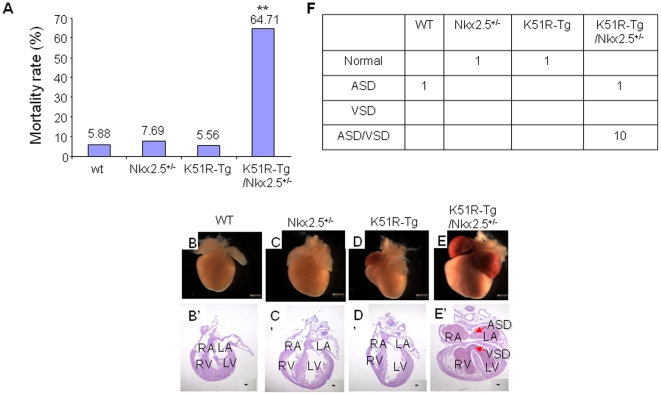
Compound K51R-Tg/Nkx2.5+/− mice exhibited ASD and/or VSD.A. Mortality rate of compound K51R-Tg/Nkx2.5+/− mice was significantly higher than those of other genotype mice. The data were collected from 65 animals of 7 litters. The number shown above each bar indicated the mortality rate of that corresponding group. B–E, Representative gross view of heart morphologies in littermate wt, Nkx2.5+/−, K51R-Tg and compound K51R-Tg/Nkx2.5+/− mice at P4 was shown. Note that the atria of the compound K51R-Tg/Nkx2.5+/− mouse heart were filled with blood. A′–D′, H&E staining on 10 µm sections of hearts corresponding to A–D was shown. Arrows in D′ indicated ASD and VSD, respectively. Scale bar, 100 µm. F. Incidence of cardiac defects in the demised mice from four genotype groups. Chi square test was used for statistical analysis. **, p<0.01, vs. other groups. RA, right atrium; LA, left atrium; RV, right ventricle; LV, left ventricle; ASD, atrial septal defect; VSD, ventricular septal defect.